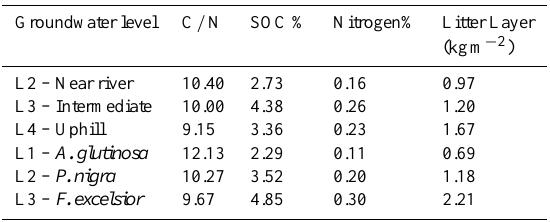
Table 1. Soil carbon and nitrogen content and dry weight of litter L and F organic horizons from soil respiration chambers.